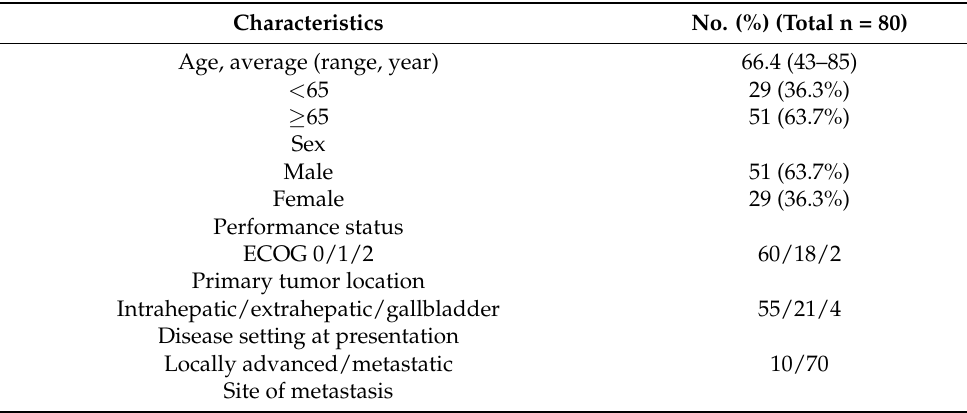
Table 1. Baseline characteristics of patients enrolled in this